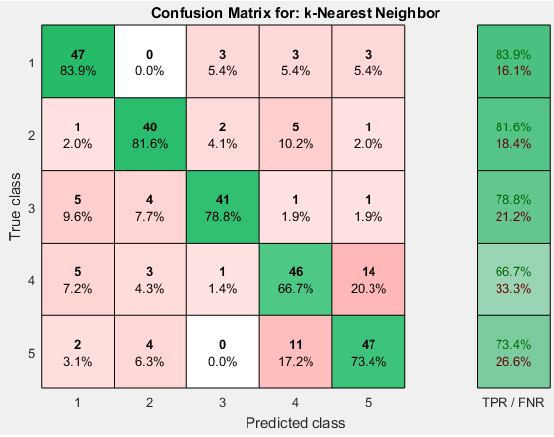
Figure 7. Confusion Matrix ( a ) Weighted KNN; ( b ) Cubic KNN.